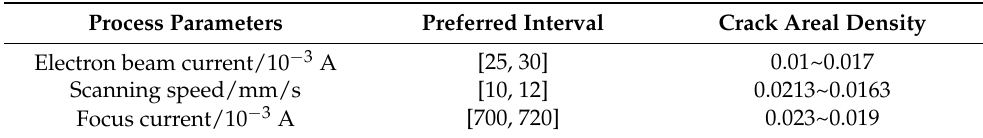
Table 6. Optimal interval of process